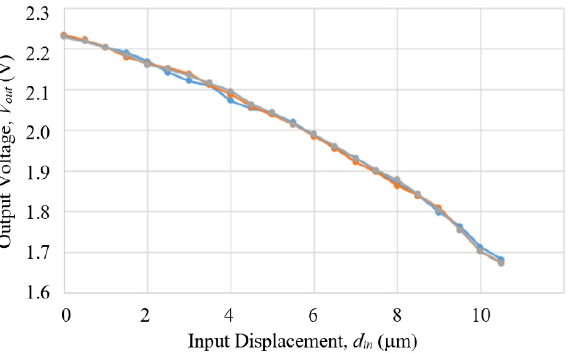
Figure 27. Results of three separate measurements of a prototype of the 25 mm compact model by using a Hall sensor and a tape magent to measure output displacement, increasing input displacement meaning decreasing gap distance between the Hall sensor and the tape magnet on the output arm.